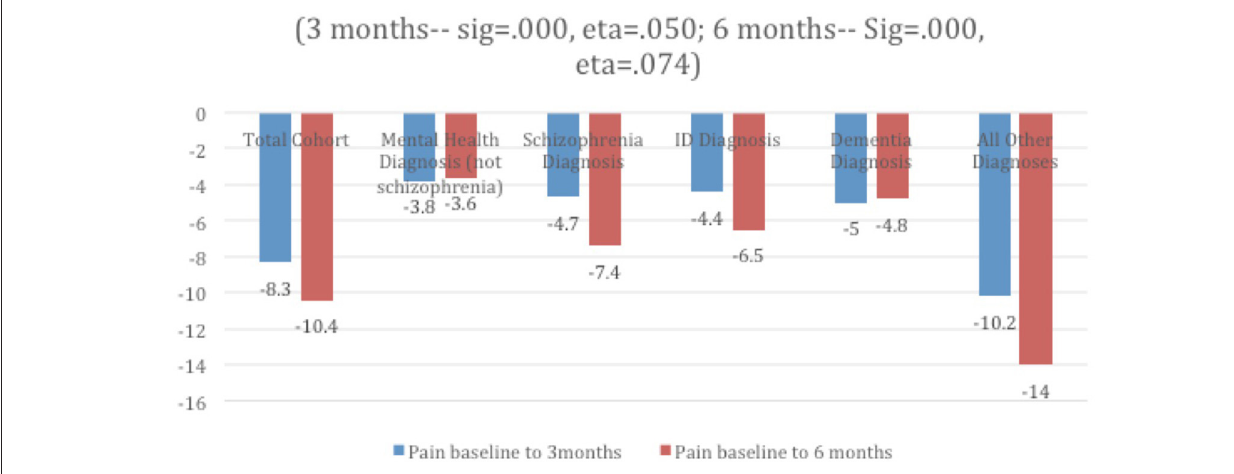
FIGURE 2 | Mean decline in pain % over time and by diagnostic group.